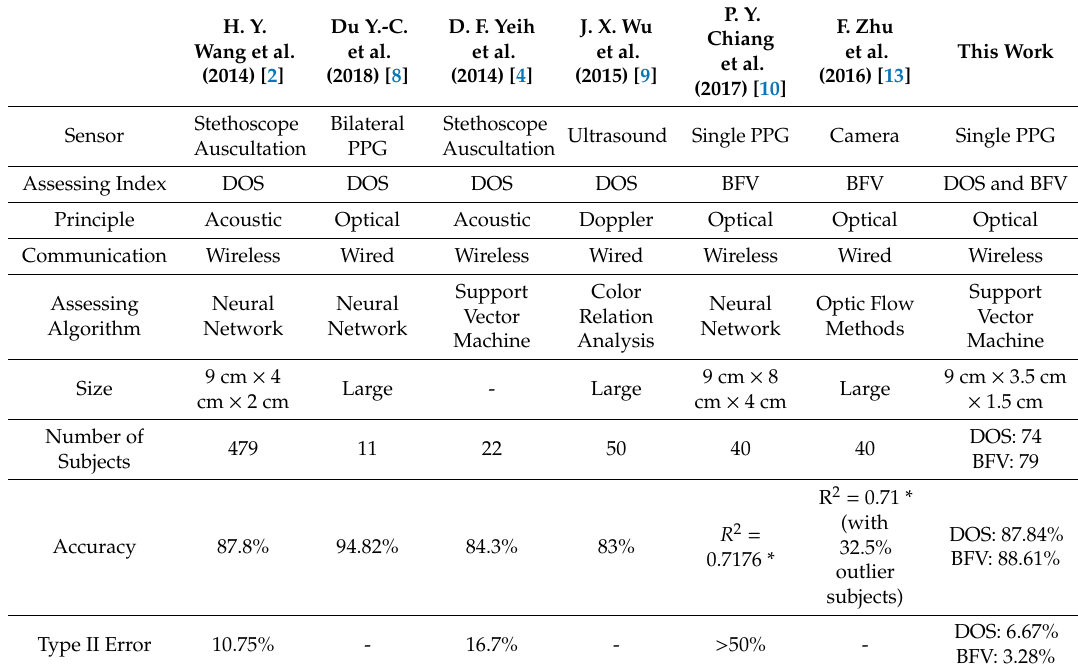
Table 4. Performance comparison table to other prior